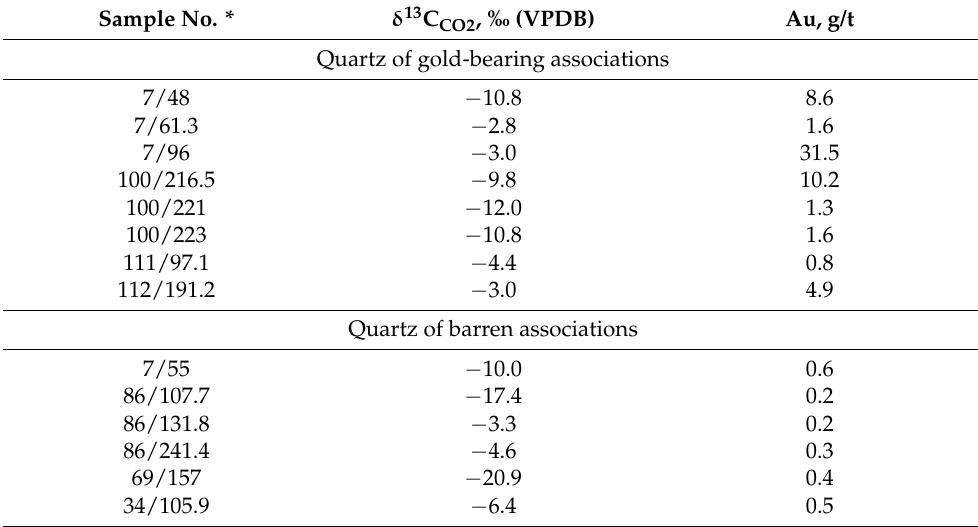
Table 5. Carbon isotopic composition ( δ 13 С ) of CO 2 and other carbon-containing compounds in fluid inclusions in quartz of the Blagodatnoye gold ore deposit.